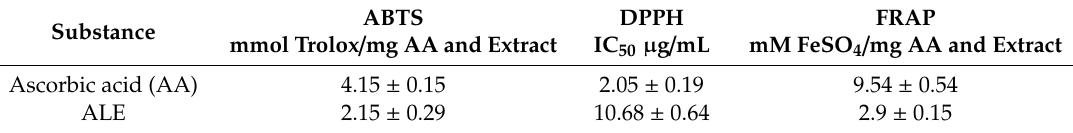
Table 1. Antioxidant activity of Uncaria tomentosa leaf extract tested by in vitro assays.